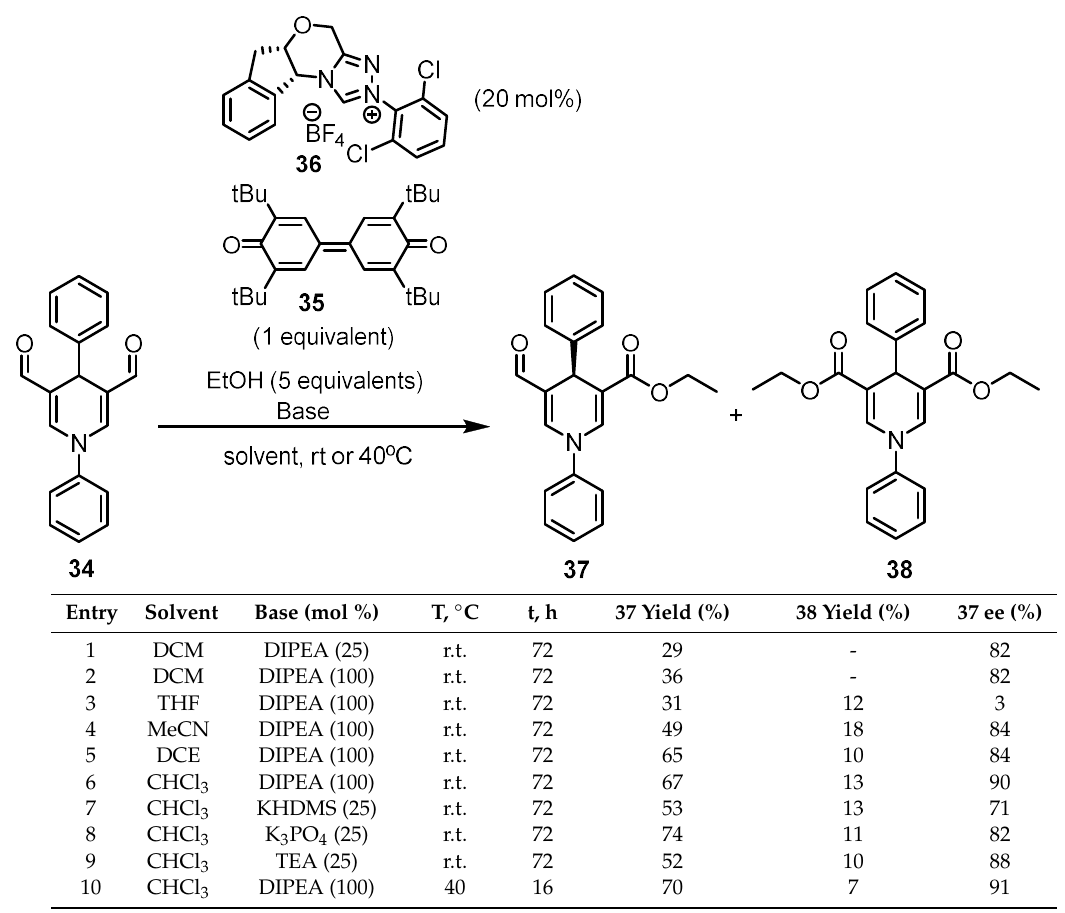
Table 12. NHC-catalysed desymmetrisation of prochiral 1,4-dihydropyridine-3,5-dicarbaldehydes 34 [70].